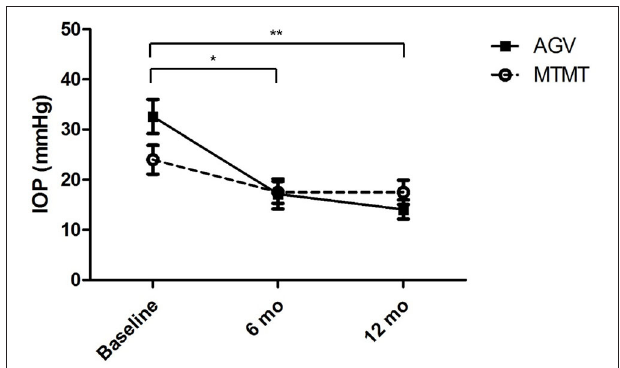
FIGURE 2 | Changes in intraocular pressure (IOP) after anti-glaucoma treatment. No significant difference was found between the two groups. There were significant IOP reductions in the AGV group between baseline and 6 or 12 months after the treatment (* p = 0.020, ** p = 0.008; Wilcoxon signed-rank test for intra-group